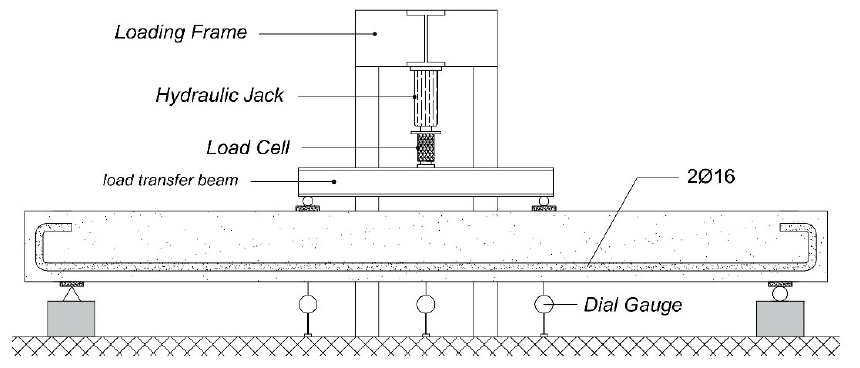
Figure 3. Beam specimen testing setup.